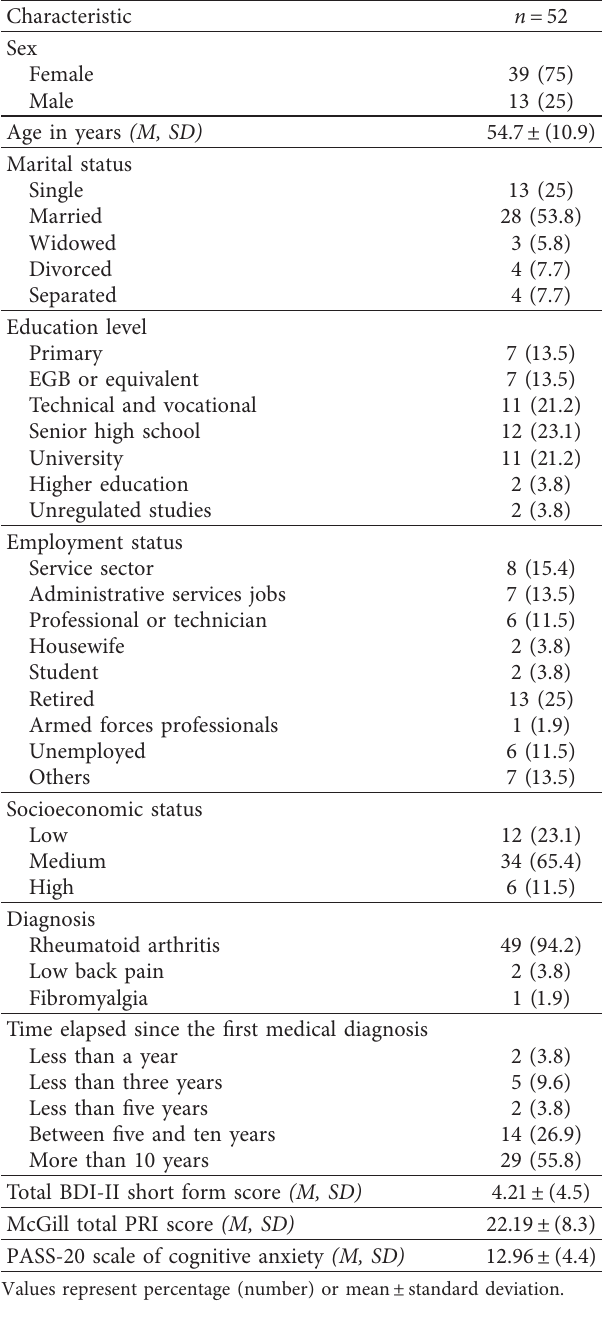
Table 2: Sociodemographic characteristics, clinical variables, and relevant questionnaire scores of